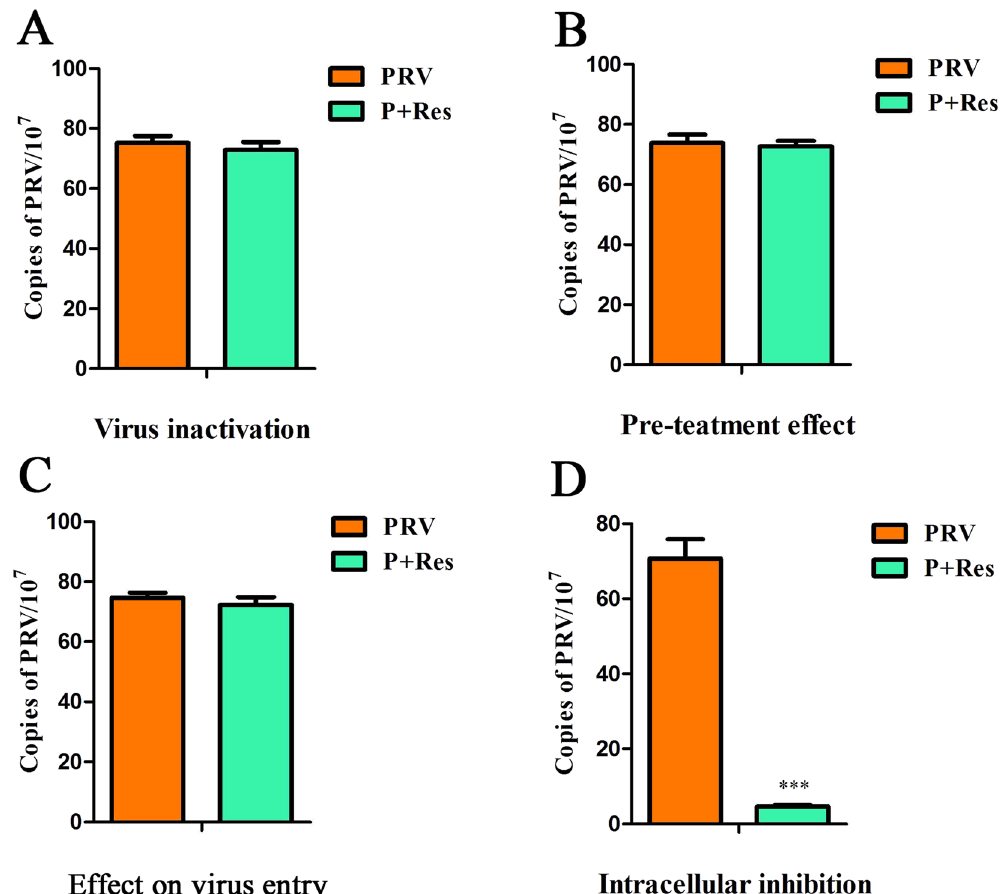
Figure 3. Influence of different treatment conditions of Res on PRV infection. Pk-15 cells infected with PRV (MOI = 0.01) were treated with Res (65.72 μ M) under different treatment conditions. Virus inactivation ( A ), Pre-treatment effect ( B ), Inhibition of virus entry ( C ), Intracellular inhibition ( D ). Values are means ± SD (n = 3). Correlation analyses were evaluated by Pearson r2, ns: p > 0.05, * p < 0.05, ** p < 0.01, and *** p < 0.001 vs. PRV-infected